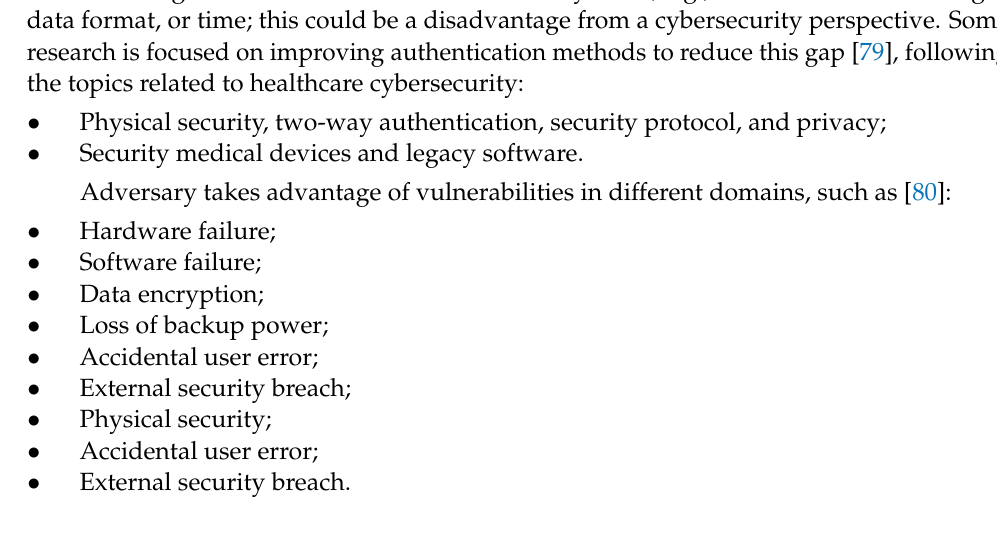
Table 7. Cybersecurity topics related to energy